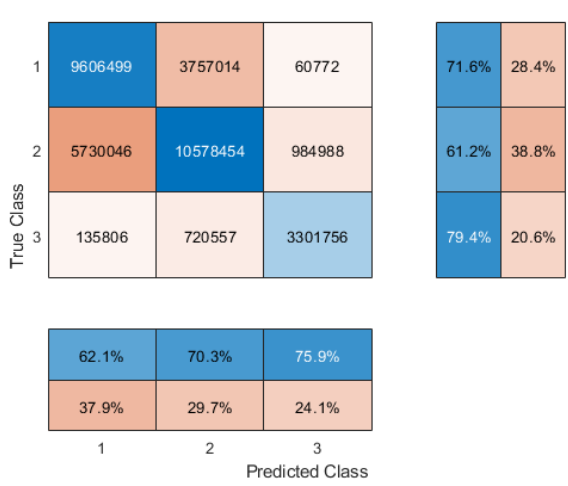
Figure 9. Confusion chart for UAV-derived point cloud; classes 1, 2 and 3 represent bare ground, low and high vegetation, respectively.